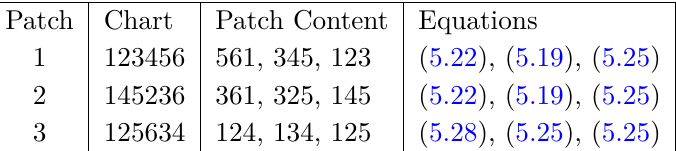
Table 1 . An atlas for the 6-point NMHV amplitude in momentum twistor space. The permutation associated with each chart is listed in the second column. The on-shell diagrams in each patch are listed in the third column, and are labelled by three momenta appearing the corresponding factorisation channel. The final column lists where the expressions in the third column can be found (some after applying either 3 ↔ 5 or 2 ↔ 4 or